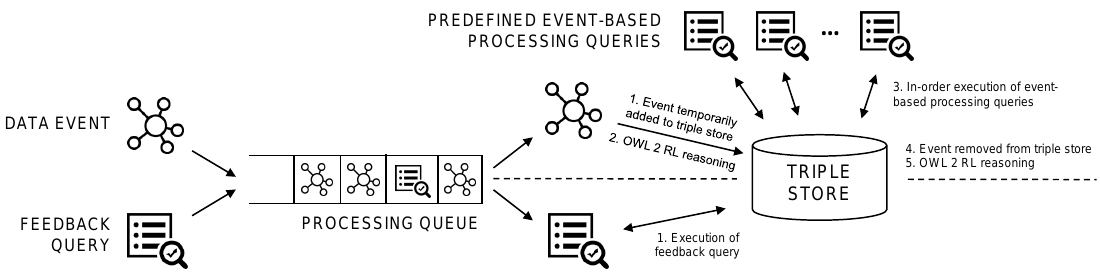
Figure 6. Overview of the functionality of the implemented reasoning service, used by the Local Reasoning Service (LRS) and Back-end Reasoning Service